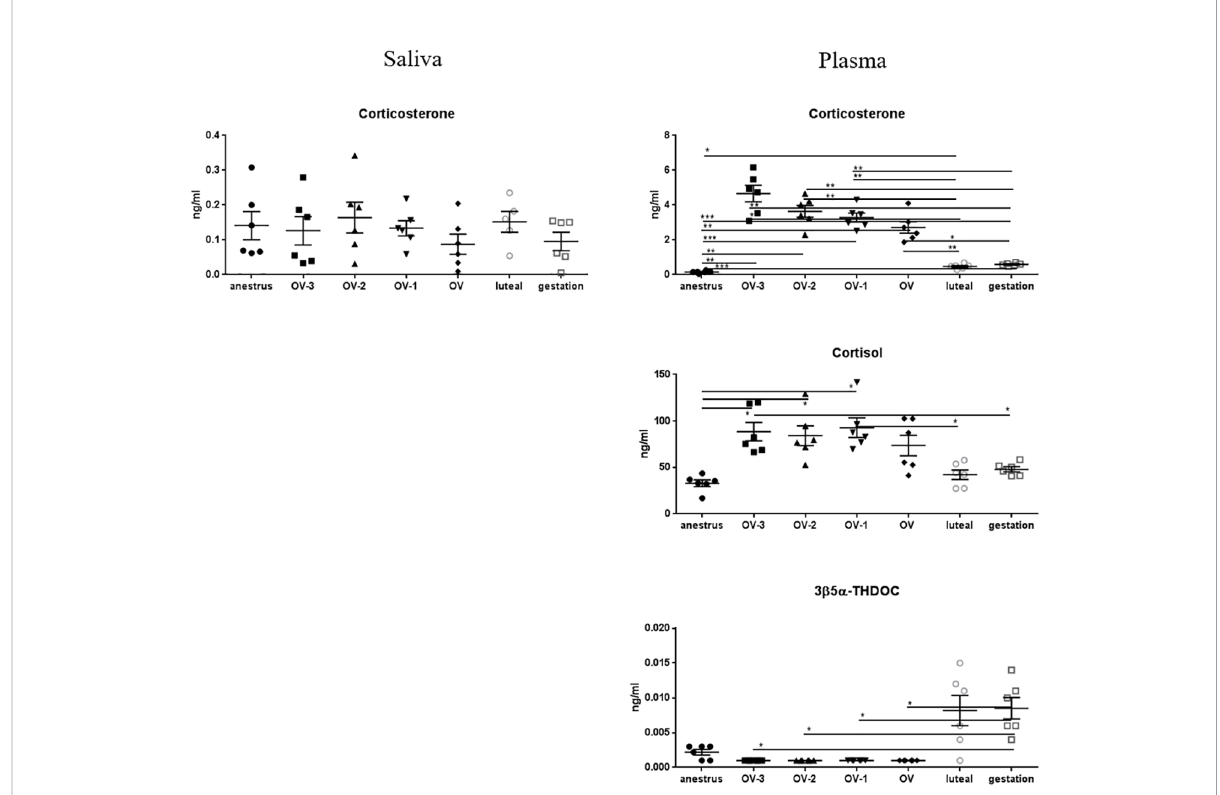
FIGURE 5 Gas chromatography coupled to tandem mass spectrometry (GC-MS/MS) measurements of the concentrations of corticosterone, cortisol and 3 b 5 a -tetrahydrodeoxycorticosterone (3 b 5 a -THDOC) (ng/mL ± SEM) in mare saliva and plasma collected during anestrus, during follicular phase 3 days (OV-3), 2 days (OV-2) and 1 day (OV-1) before ovulation, the day when ovulation was detected (OV), during luteal phase 6 days post- ovulation (luteal), during gestation 18 days post-ovulation (gestation). For each steroid, the y-axis was standardized to the